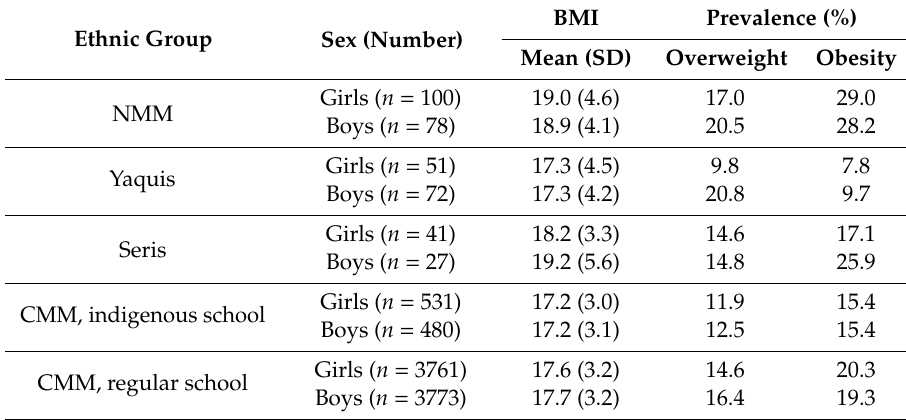
Table 1. Descriptive results: number of children (n), mean and standard deviation (SD) of body mass index (BMI), overweight and obesity prevalence for girls and boys of each ethnic group (NMM: Northern Mexican Mestizos, CMM: Central Mexican